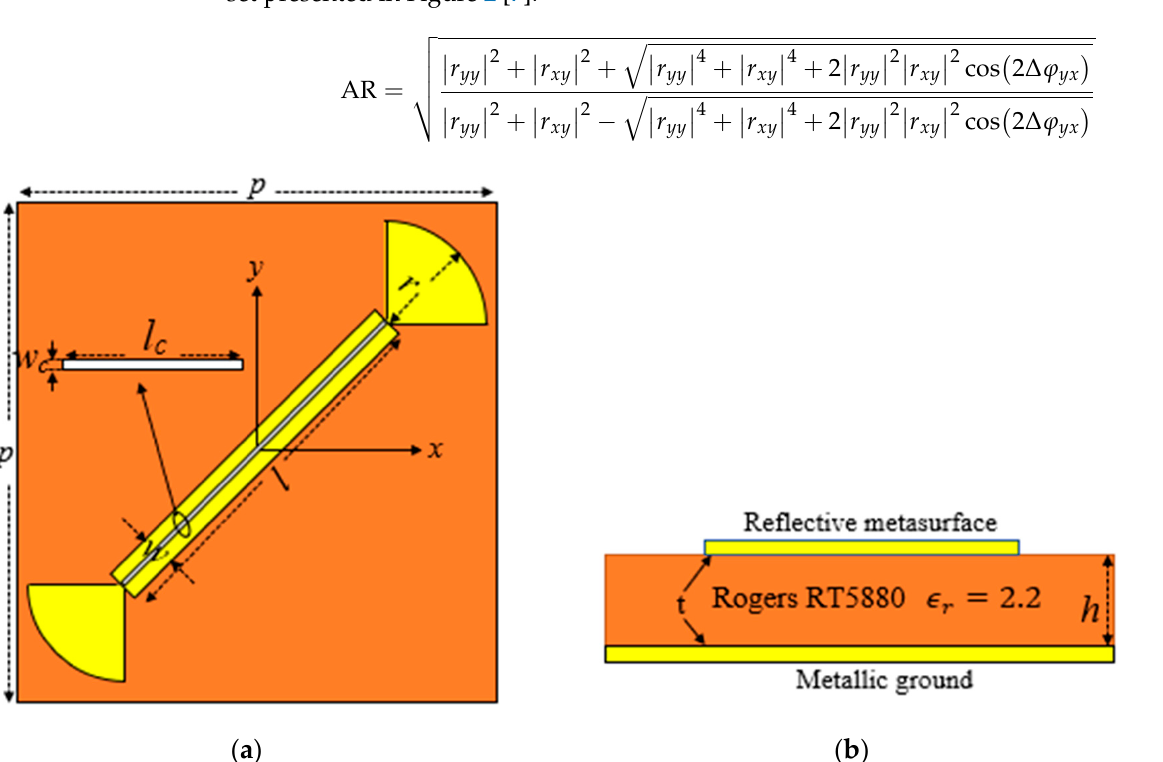
Table 1. Optimized value (in mm) of the reflective metasurface unit cell.